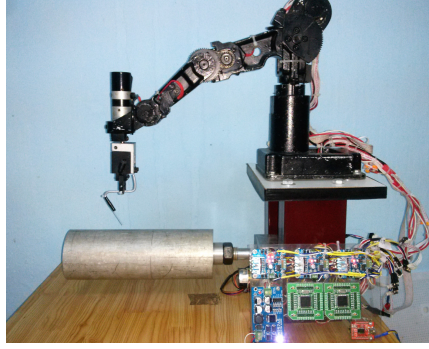
Fig. 15: Experimental Robot system.